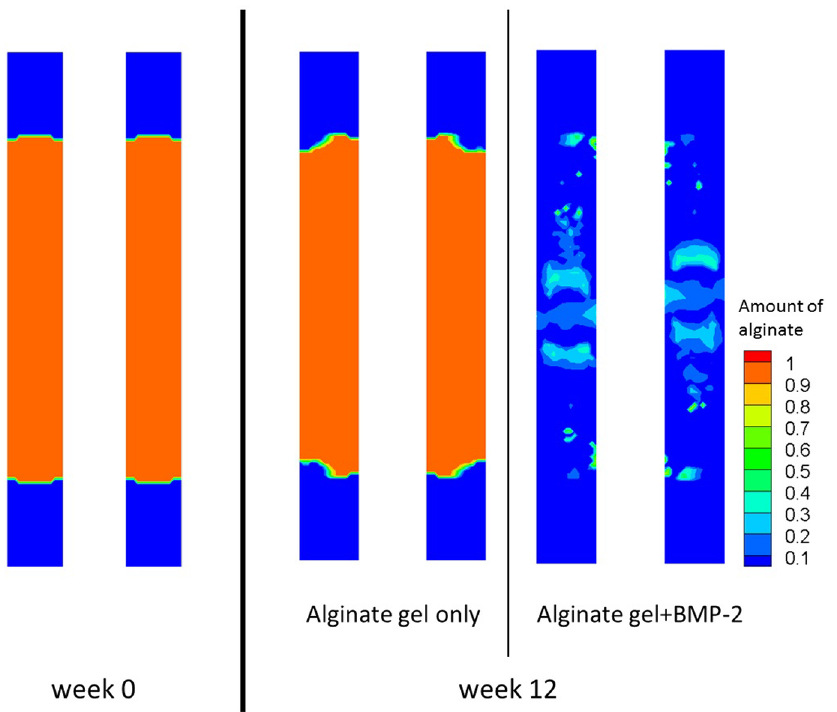
Fig 11. Alginate hydrogel normalised distribution inside the bone defect. Alginate hydrogel normalised distribution inside the bone defect after 12 weeks, for the case where alginate alone is implanted inside the bone defect and for the case where alginate with 5 μ g of BMP-2 is implanted inside the bone defect.